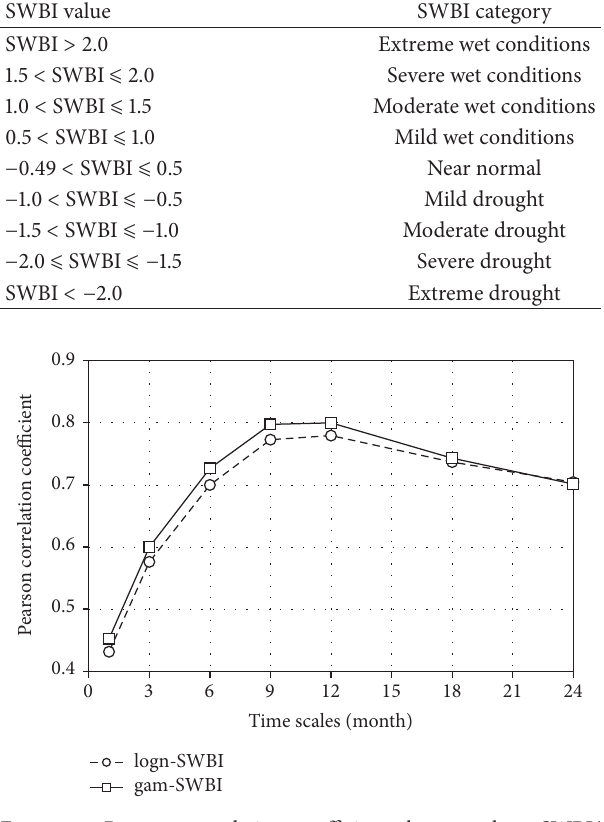
Figure 5: Pearson correlation coefficients between logn-SWBI/ gam-SWBI and sc-PDSI.